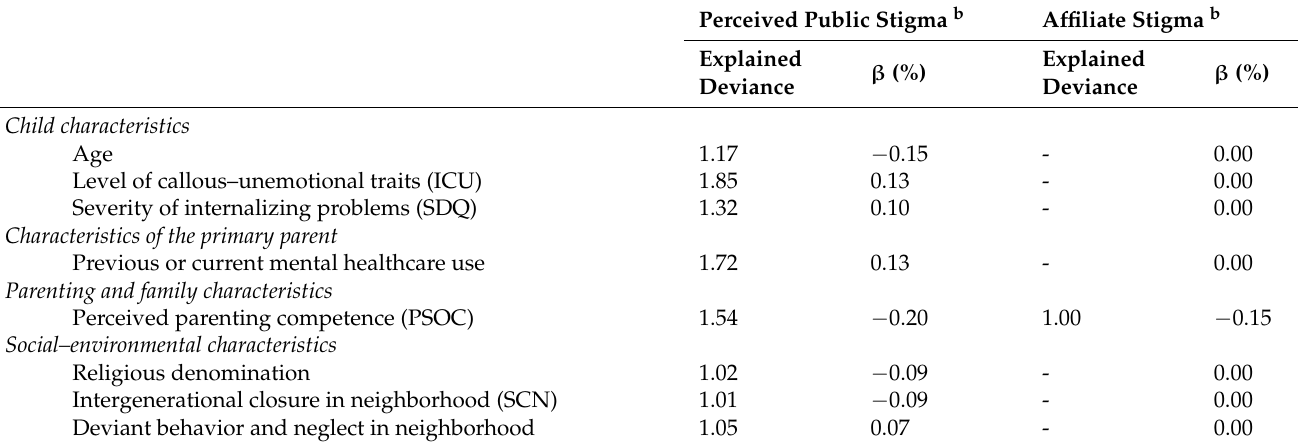
Table 2. Relevant predictors of parents’ perceived public stigma and affiliate stigma (PPSSS, n = 312) a